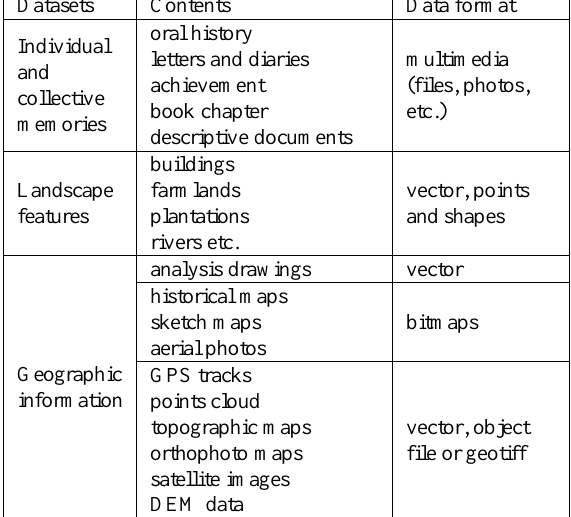
Table 1 The structure of the Kuliang geo-database Data processing